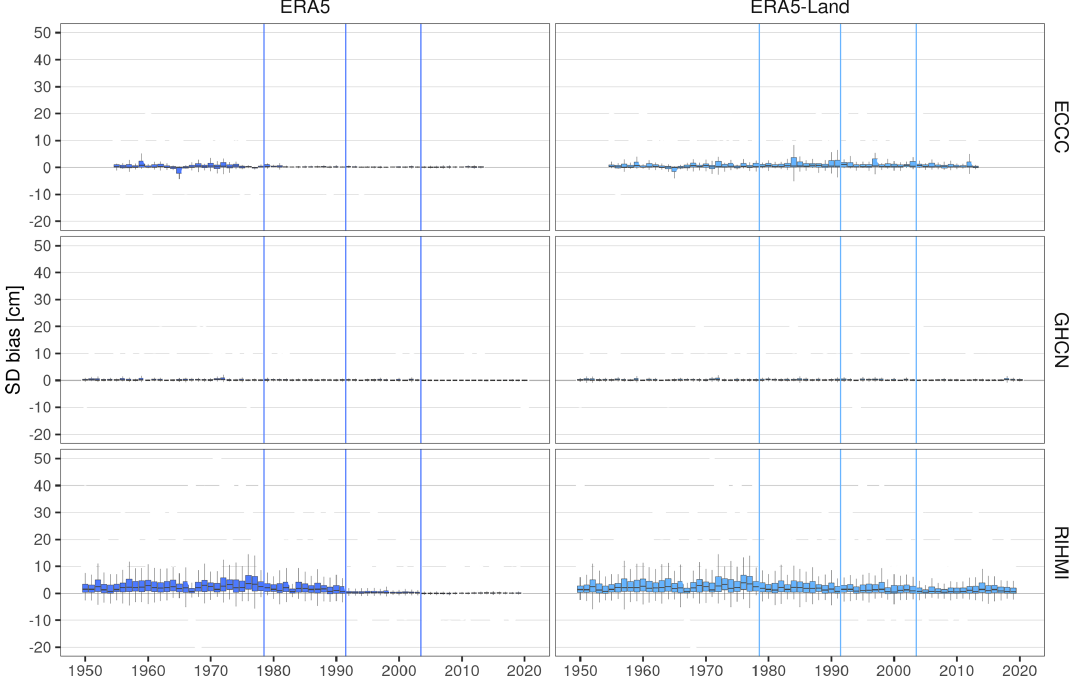
Figure A3. Temporal stability of the bias (product – station) in snow depth (SD) per product and network during SON. Vertical lines show the years when the potential discontinuities in each product